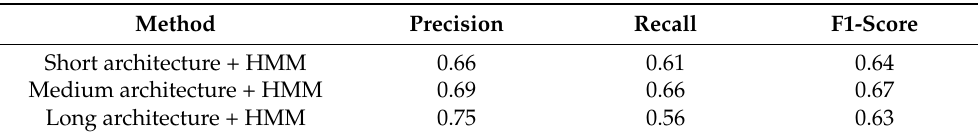
Table 2. Results of the deep learning (DL) models in combination with Hidden Markov Model (HMM) obtained from our dataset—eating segment